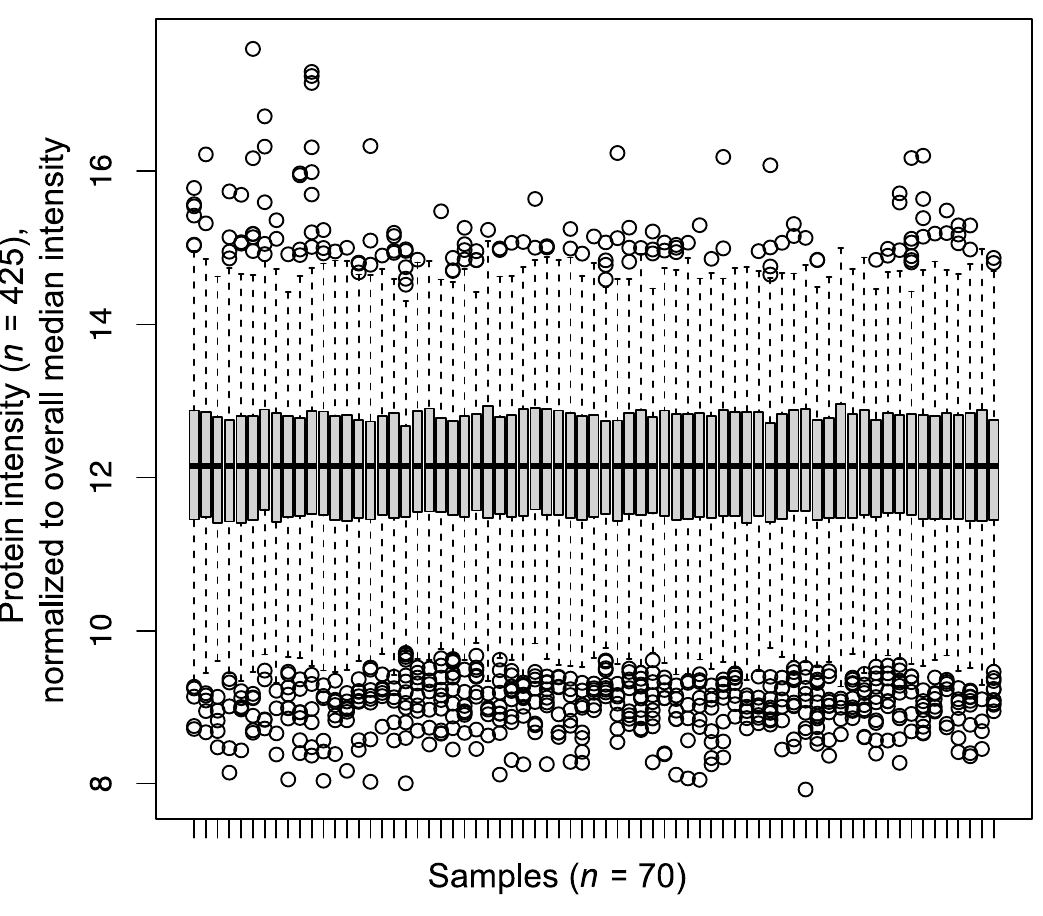
Figure 2. Boxplot depicting the median-normalized protein intensities for 70 serum samples of the present cohort.